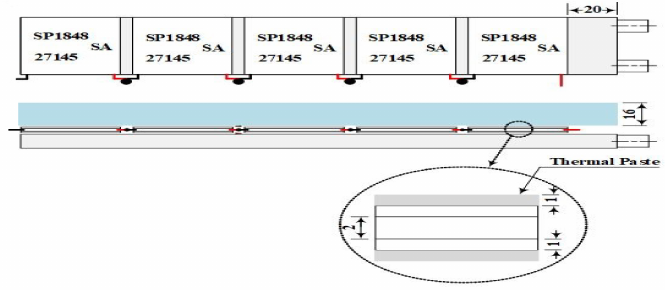
Figure 6. A schematic view of one row of the TEG board consisting of two sections, each with 5